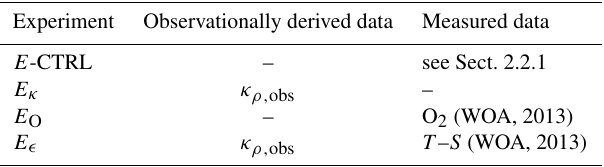
Table 2. Listed are the ECCO simulations performed and analyzed in the present study as well as the observationally derived data or measured data included in each simulation. Either observation- ally derived data or measured data are included in the experiments through a misfit calculation (Eq. 1). Here, κ ρ, obs denotes an ob- servationally derived κ ρ product derived from a parameterization ( κ ρ, Argo and κ ρ, CTD or κ ρ, tides ) or inferred from microstructure ( κ ρ, micro ), (cid:15) = κ ρ N 2 / 0 . 2 indicates an observationally derived dis- sipation rate ( N 2 is the stratification from the World Ocean Atlas or WOA, 2013), and O 2 is the climatology of measured oxygen con- centrations from WOA (2013). The misfits for the experiments with κ ρ and (cid:15) are calculated using Eq.